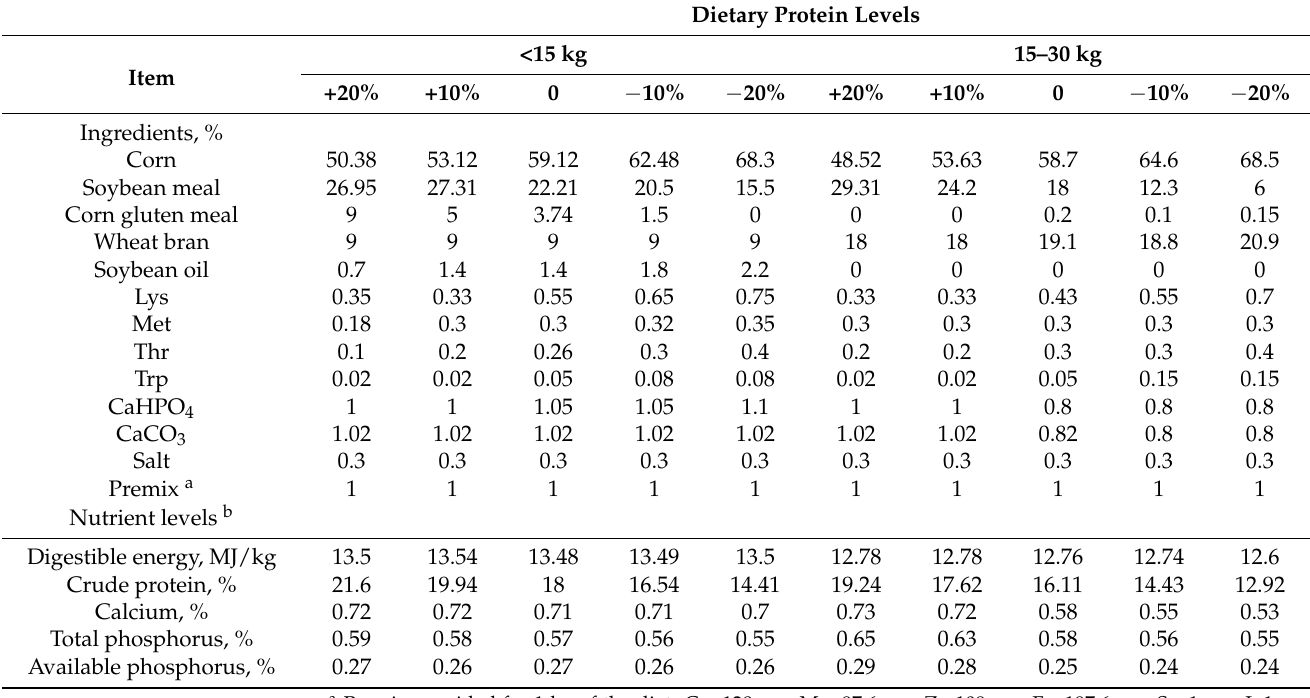
Table 1. Ingredients and nutrient levels of the experimental diets for Shaziling pigs (<15 kg and 15~30 kg) (air-dried, %). Dietary Protein Levels